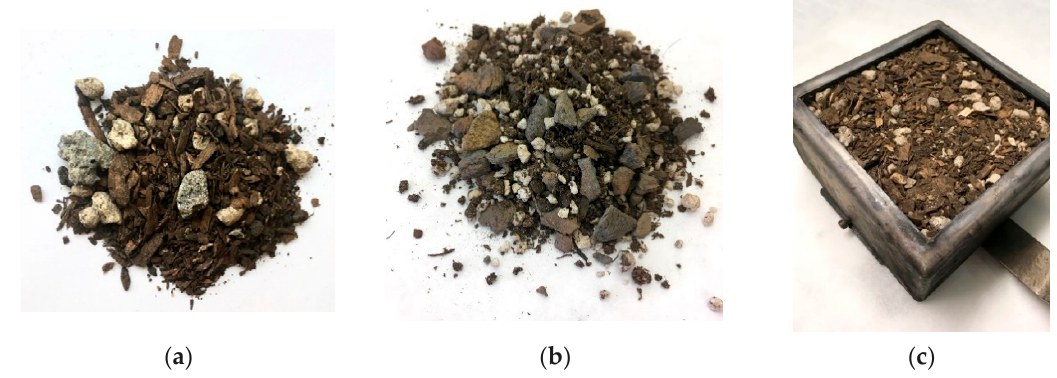
Figure 2. Samples: ( a ) Substrate 1; ( b ) Substrate 2; ( c ) sample in a holder.